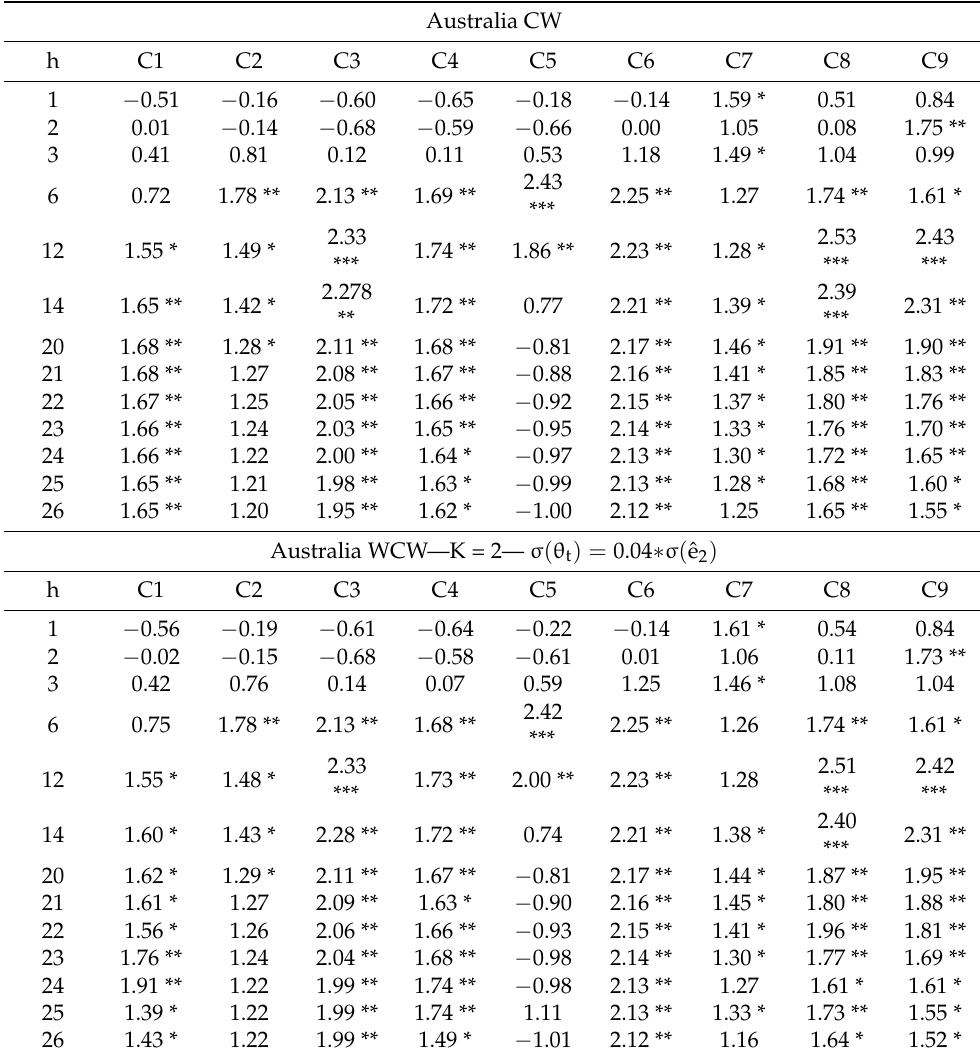
Table 15. Forecasting commodity prices with the Australian exchange rate. A comparison between CW and WCW in iterated multi-step-ahead